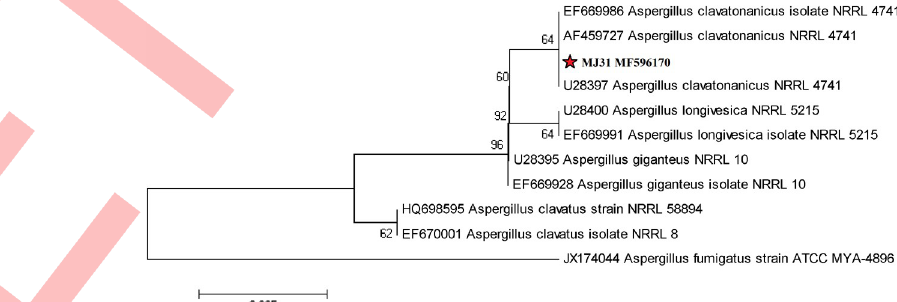
Fig 2. A neighbor joining tree revealing the evolutionary relationship among the endophytic fungus MJ31 and the BLAST analysis tool along with the nine type strains retrieved from NCBI GenBank databases based on 28S rRNA sequences. The bootstrap values were depicted based on 1000 replications, whereas Aspergillus fumigatus strain ATCC MYA-4896 was taken as an